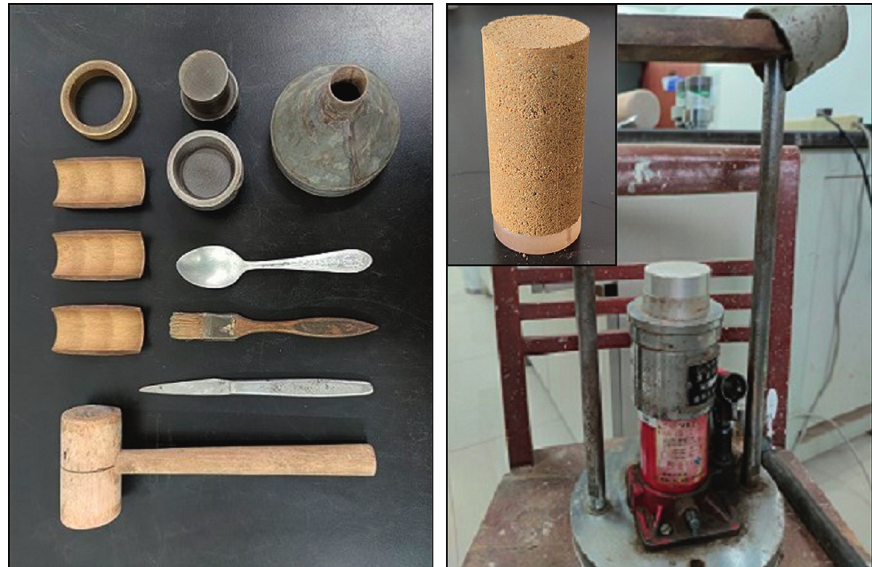
Figure 5: Stratified sample preparation device.